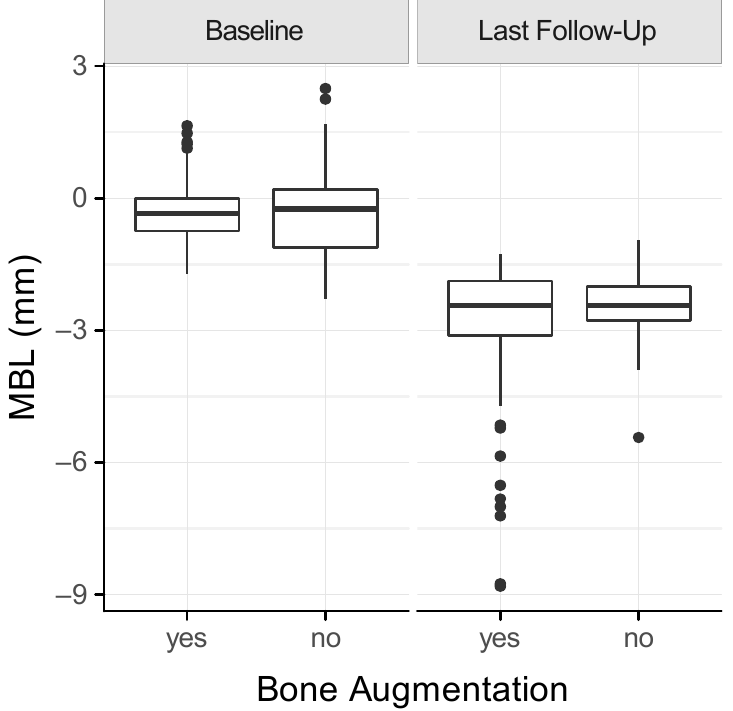
Figure 4. Box plot of the marginal bone loss (MBL) at the time of implant placement (baseline) and the last follow-up.